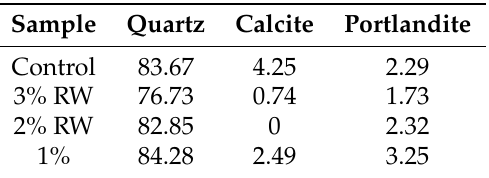
Table 5. The relative phase amounts (weight